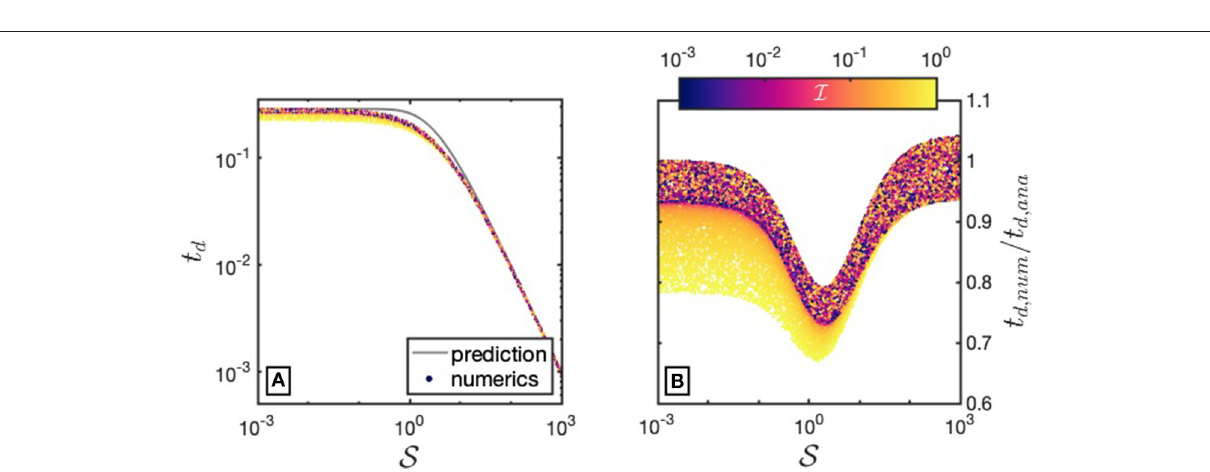
FIGURE 6 | Detachment times t d for a simulation subset with I < 1 (low grain damage). (A) t d as a function of the thermal damage parameter S . Colors denote the value of I for each simulation. The gray line denotes the analytical prediction for shear heating dominated weakening (Equation 50). (B) Ratio t d , num / t d , ana between the numerically computed detachment time and the analytically predicted one. As in (A) , colors denote the value of I for each